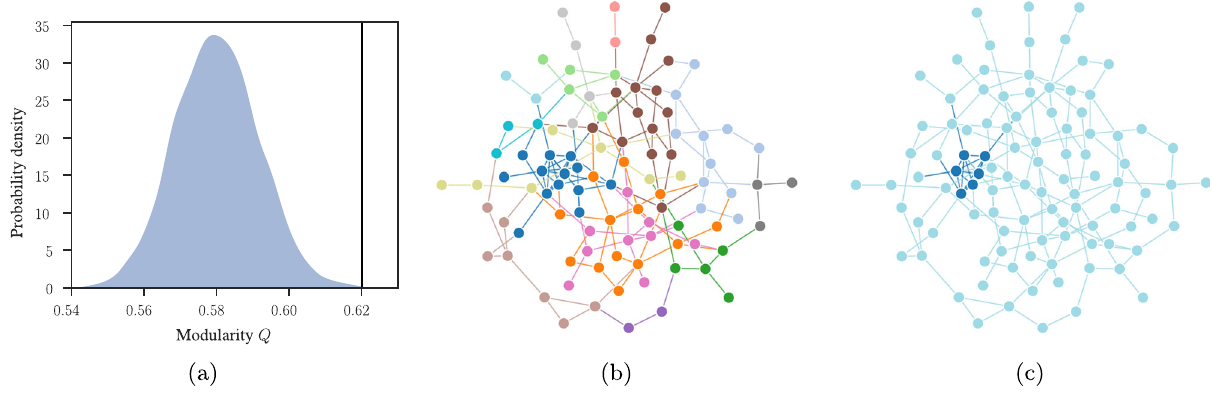
Fig. 3 | Evaluating community structure with null and generative models. a Distribution of maximum modularity value Q for a null model of a fully random network with N =100 nodes. The vertical line marks the value encountered for a modi fi edversionofthenetworkwithanembeddedcliqueof6nodes,asdescribed